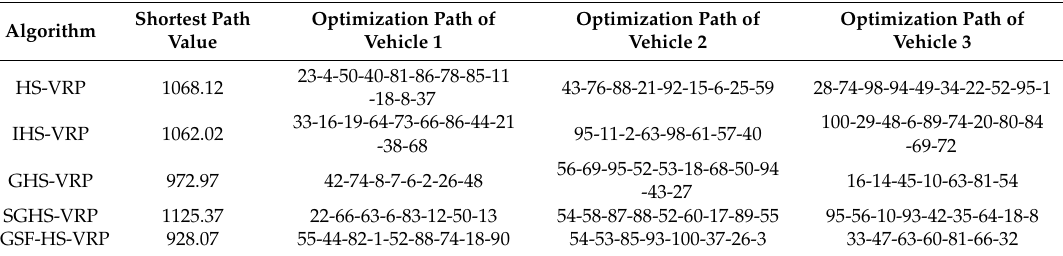
Figure 4. Average optimum iteration curve of each algorithm. Table 7. Comparison results of vehicle routing optimization of each algorithm.